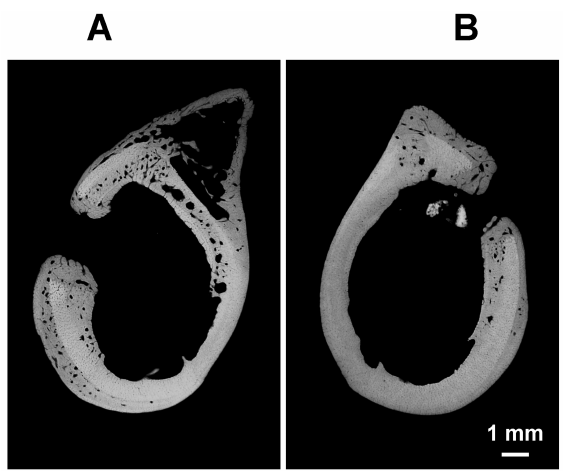
Figure 2. Representative microradiographs of two transverse sections taken at the central part of control hole ( A ) and BGSr filled hole ( B ), 60 days after the surgery. Note in both microradiographs how the hole wall has been greatly remodeled and that new bone (dark gray) now replaces the resorbed pre-existing bone. Note also how the transverse diameter of the control hole ( A ) is almost twice the corresponding diameter of the BgSr filled hole ( B